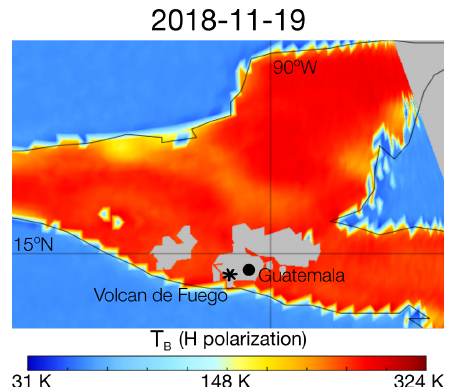
Figure 4. A typical SMAP observation of Central America. Gaps in the L1C data product are the result of mitigation of anthropogenic radio frequency interference (RFI), which increases in heavily populated areas. Presumably, anthropogenic RFI will not be a problem on other planets in the near future. North is up.